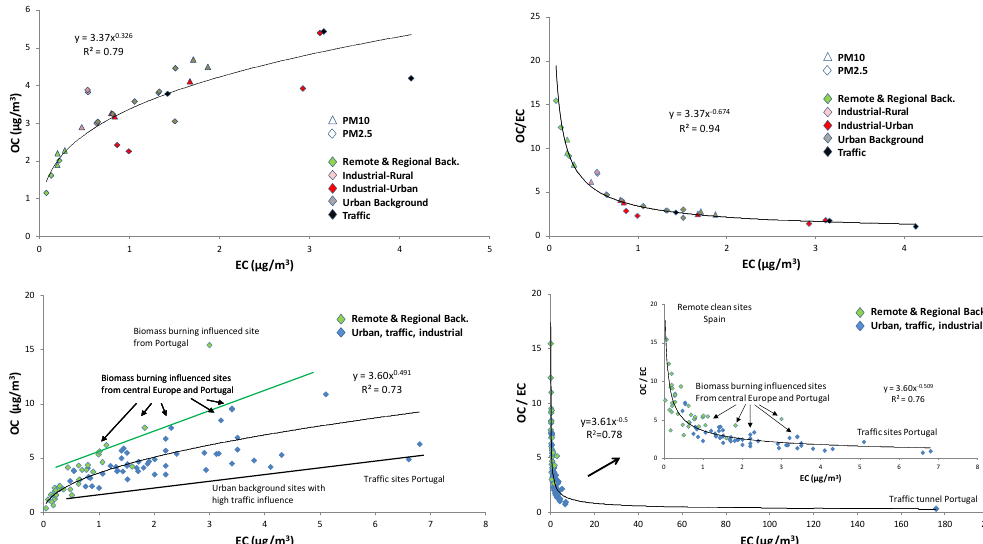
Figure 7. Correlation and regression equations between mean OC and EC levels (two left) and the ratios OC/EC with EC levels (two right) obtained in this study for Spanish only (two top) and Spanish and other European (bottom) sites (Ytri et al 2007, Pio et al 2007 and 2011, and Grivas et al 2012, and references therein).